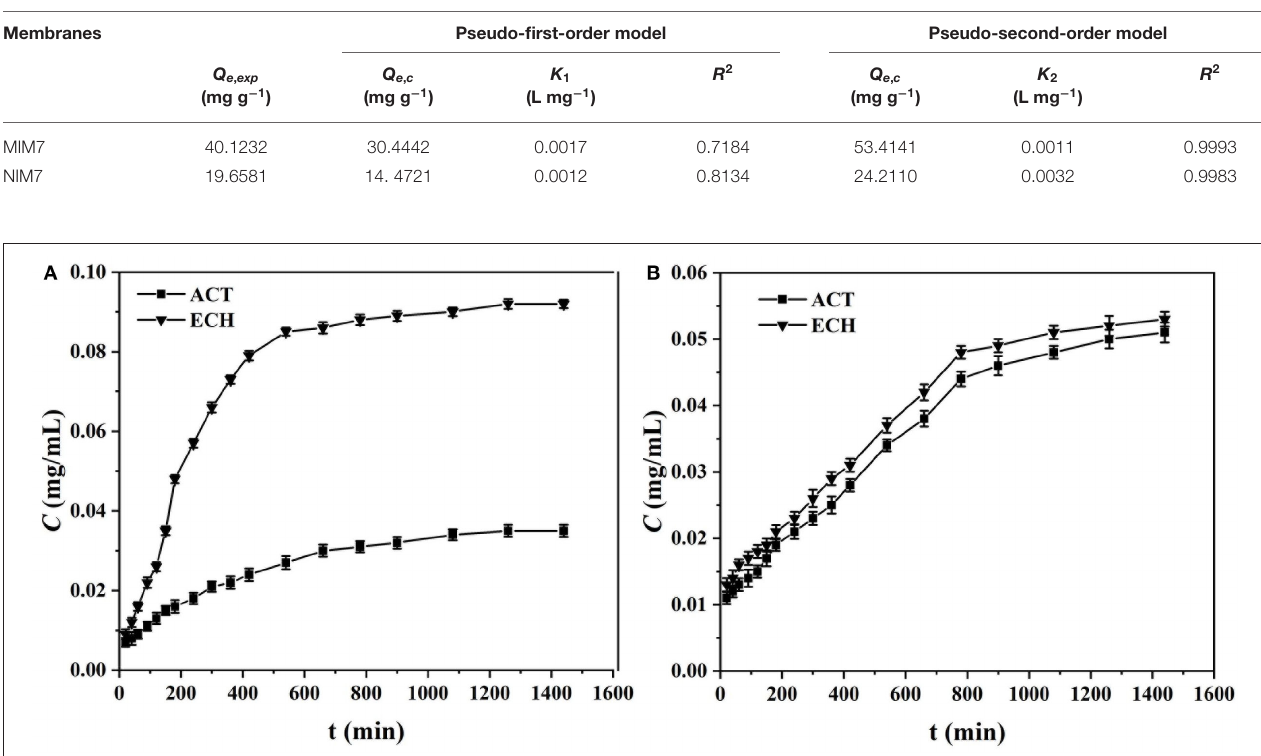
FIGURE 6 | Time-dependent permselectivity curves of various targets (ACT and ECH) through (A) MIM7 and (B)